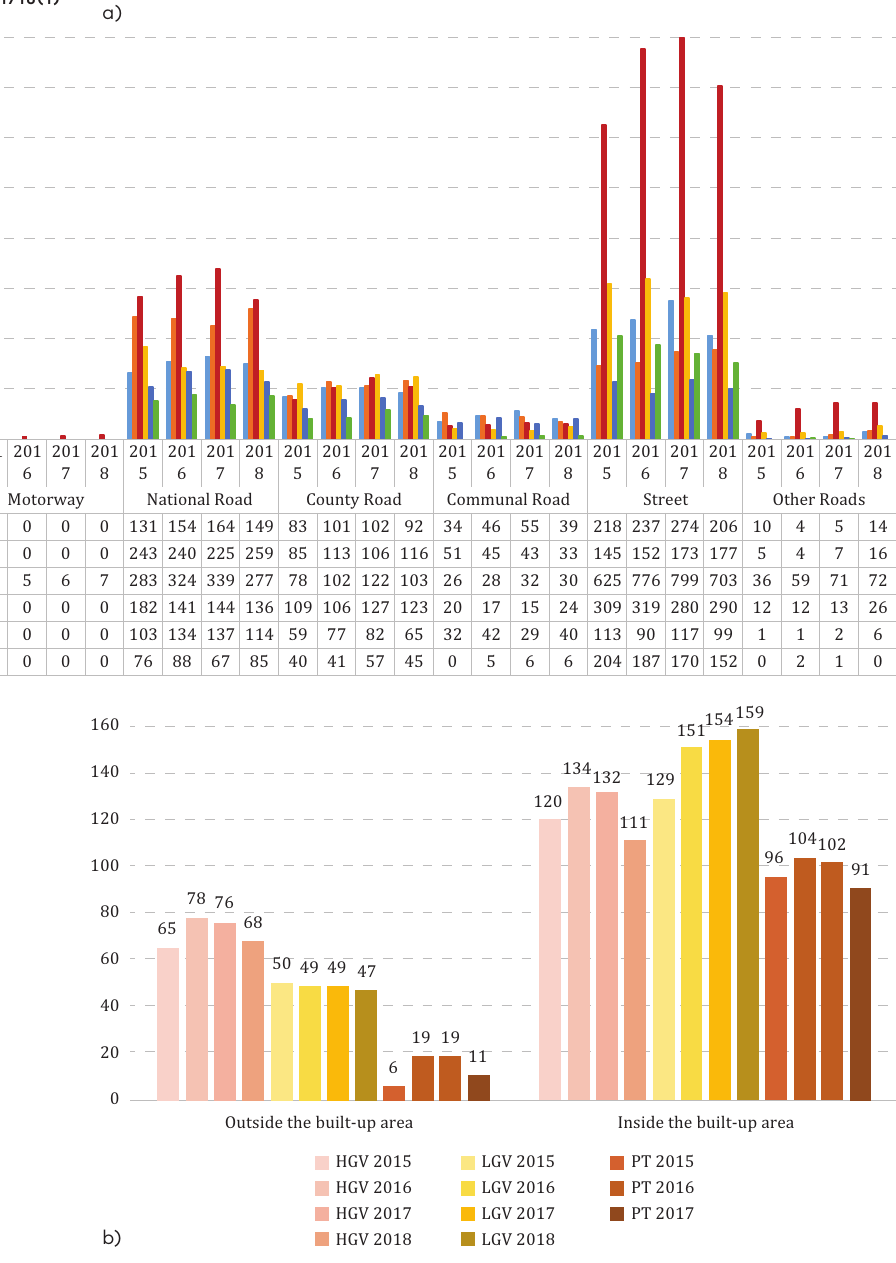
Figure 3. Accidents involving HGV, LGV and PT vehicles in the N-W Region between 2015 and 2018: a) incidence by type of road; b) incidence in